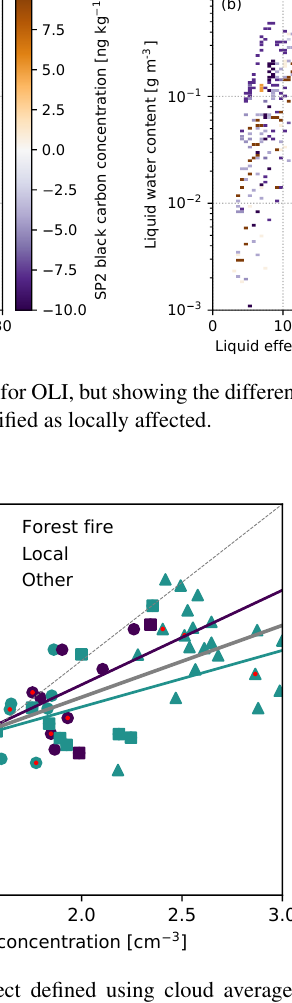
Figure 14. Aerosol indirect effect defined using cloud averaged cloud drop concentration N tot and PCASP aerosol concentration N a obtained below cloud. The colours differentiate between OLI (green) and NSA (purple). Clouds classified as anthropogenically impacted, related to forest fires, and remaining other cloud are marked with squares, triangles, and circles, respectively. Red dots indicate clouds where the aerosol concentration above the cloud is higher than below the cloud. The trend lines indicate the linear re- gressions to obtain ACI (excluding forest fires) for the complete data set (grey), NSA (purple), and OLI (green); the dotted line is the 1 : 1